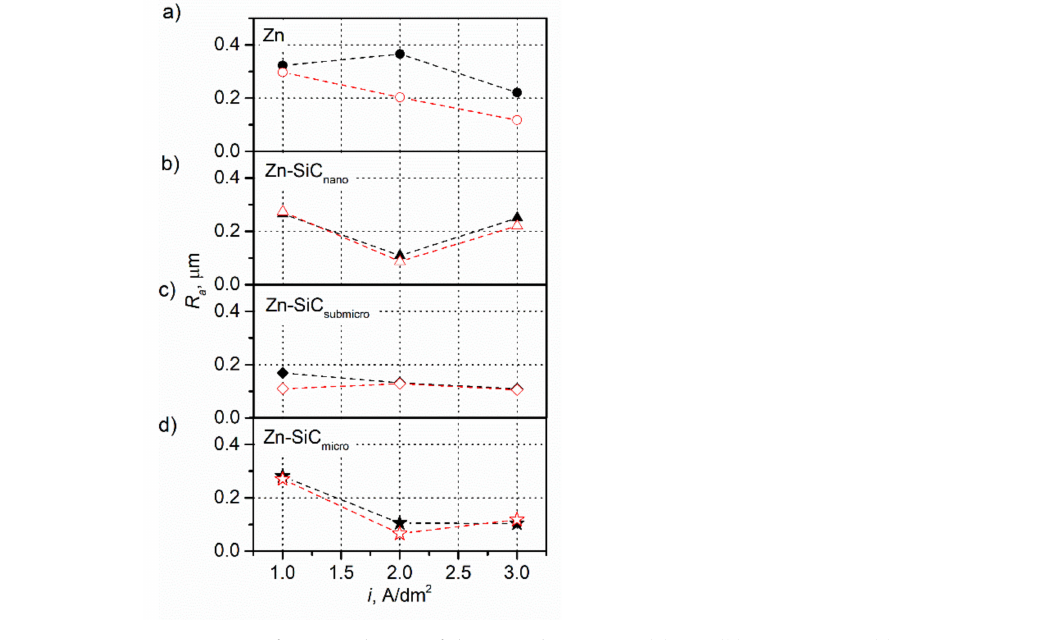
Figure 4. Surface roughness of deposited coatings: ( a ) Zn, ( b ) Zn-SiC nano , ( c ) Zn-SiC submicro , and ( d ) Zn-SiC micro (black—no ultrasound,